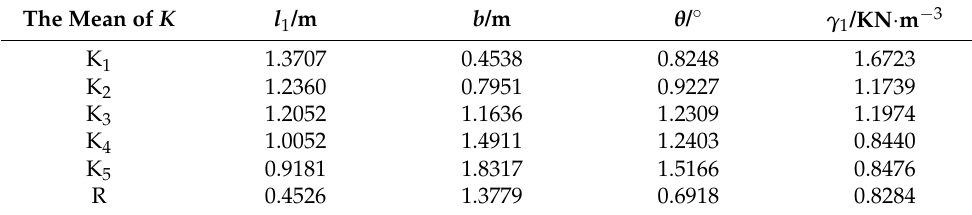
Table 3. Stability coefficient range analysis